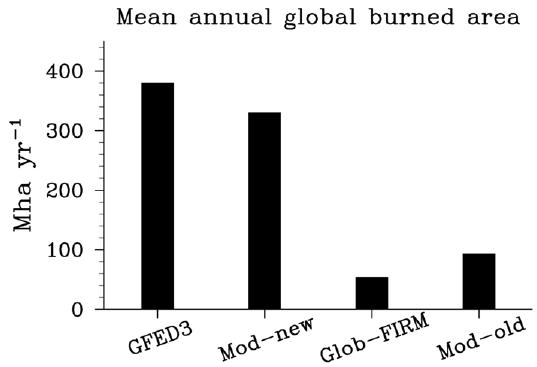
Fig. 7. 1997–2004 mean annual global burned area: GFED3 and CLM-DGVM simulations with the new fire parameterization (Mod- new), the commonly used Glob-FIRM (Glob-FIRM), and the old fire parameterization in CLM-DGVM